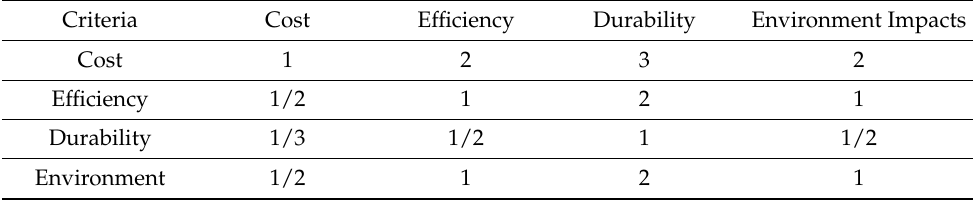
Table 3. Criteria weight matrix by